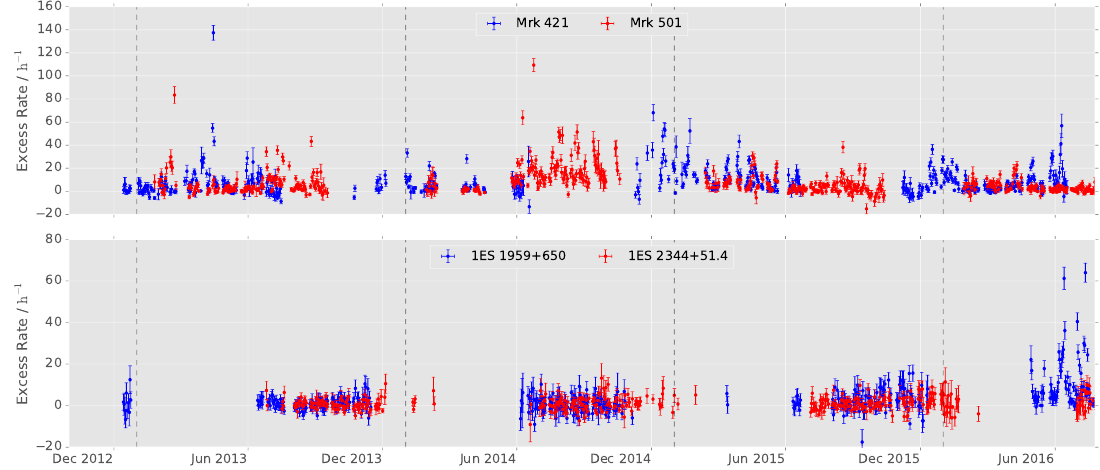
Figure 5. Daily binned excess rate curves for the main sources measured by FACT. The sources are monitored during the visibility periods each year. Holes during these visibilty periods are mainly caused by bad weather conditions.